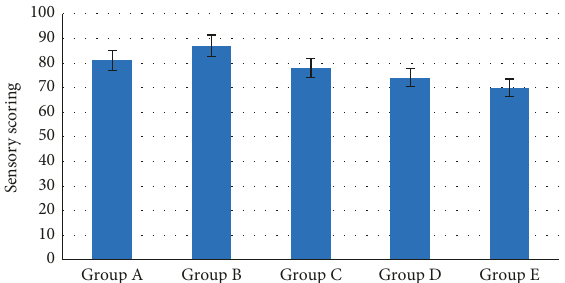
Figure 10: Variation of sensory scores with the amount of sugar added ( P < 0 .